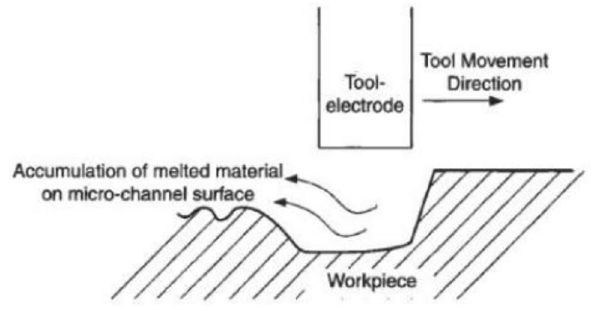
Fig. 1 Schematic of machining operations with electrochemical discharge